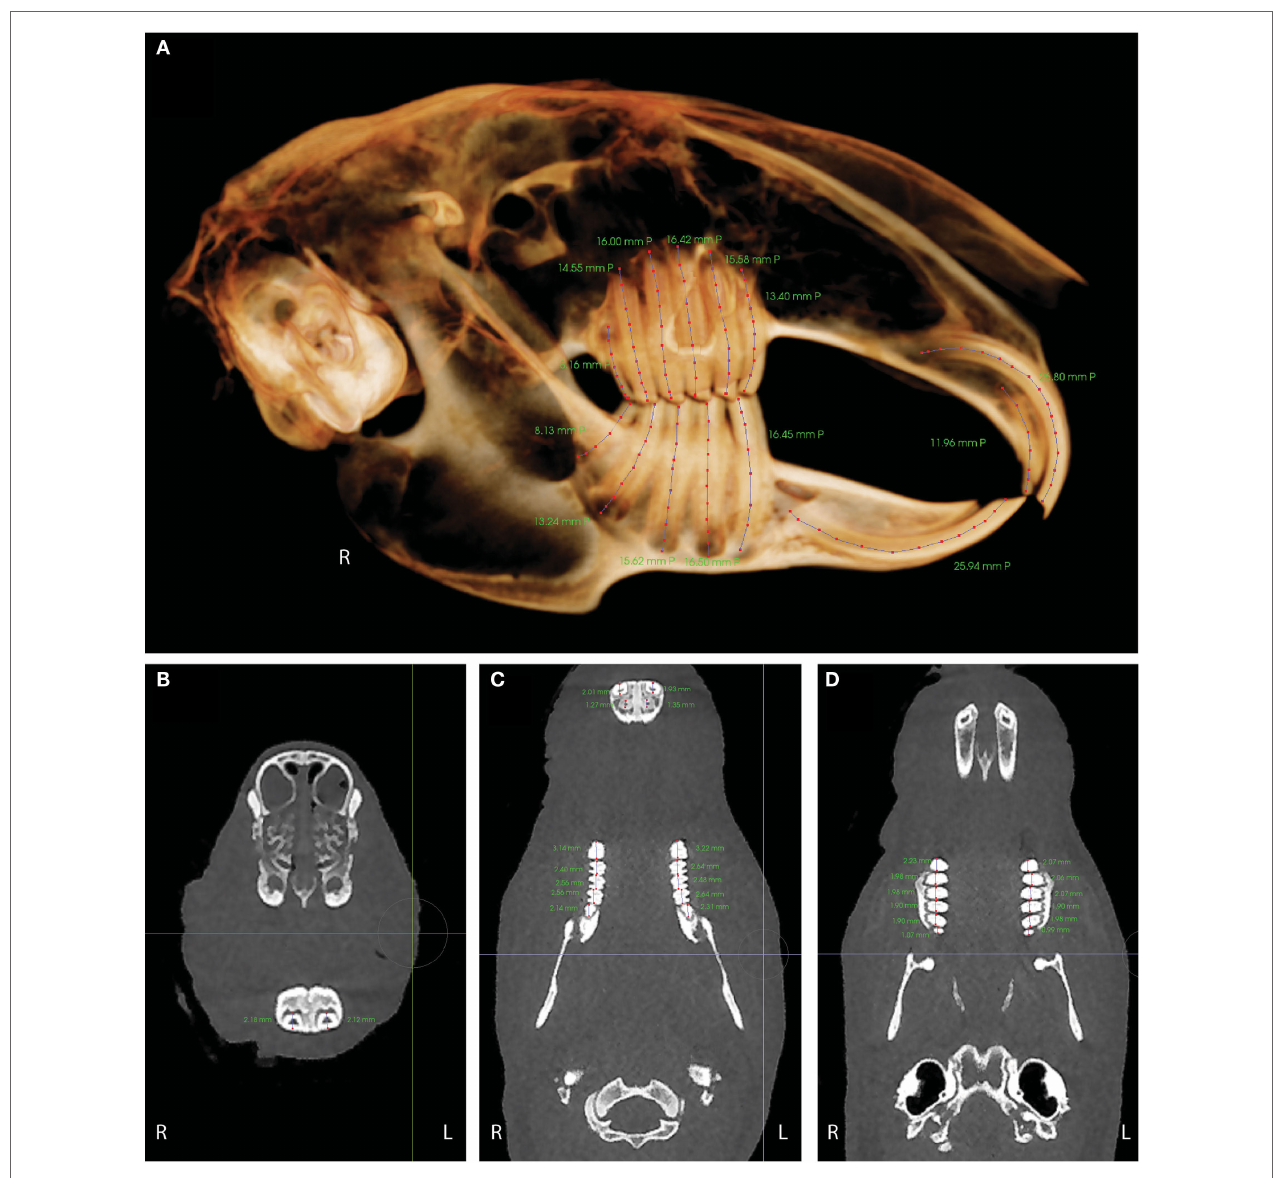
FigUre 3 | (a) Tooth length measurements in right lateral tooth view. mmP indicates the length in millimeters was performed on the two-dimensionally flattened volume rendered image. (B) The width of the mandibular incisor teeth was measured in a dorsoventral direction on a transverse image at the level of the teeth where they are the most ventral within the mandible. (c) Tooth widths for the mandibular premolar and molar teeth (middle of image) and the maxillary incisor teeth (top of image). (D) Tooth widths for the maxillary premolar and molar teeth. Tooth widths were evaluated in a rostral-to-caudal direction on a dorsal view image at the level of the alveolar